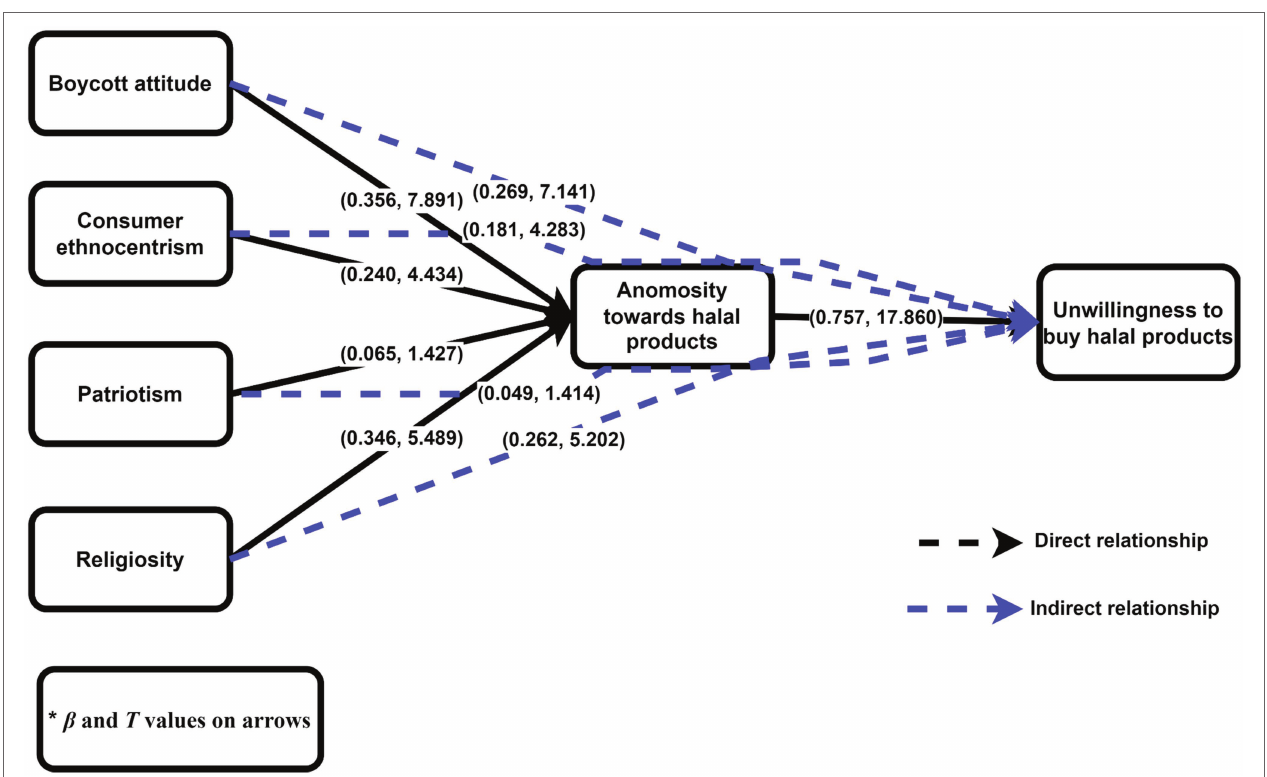
FIGURE 3 | Path coefficient results of the